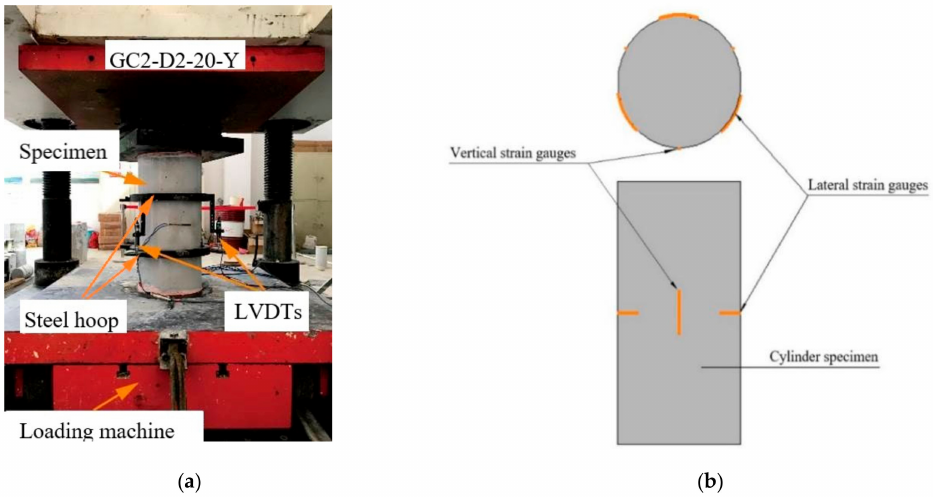
Figure 3. Test set-up and location of strain gauges. ( a ) Test set-up. ( b ) Locations of strain